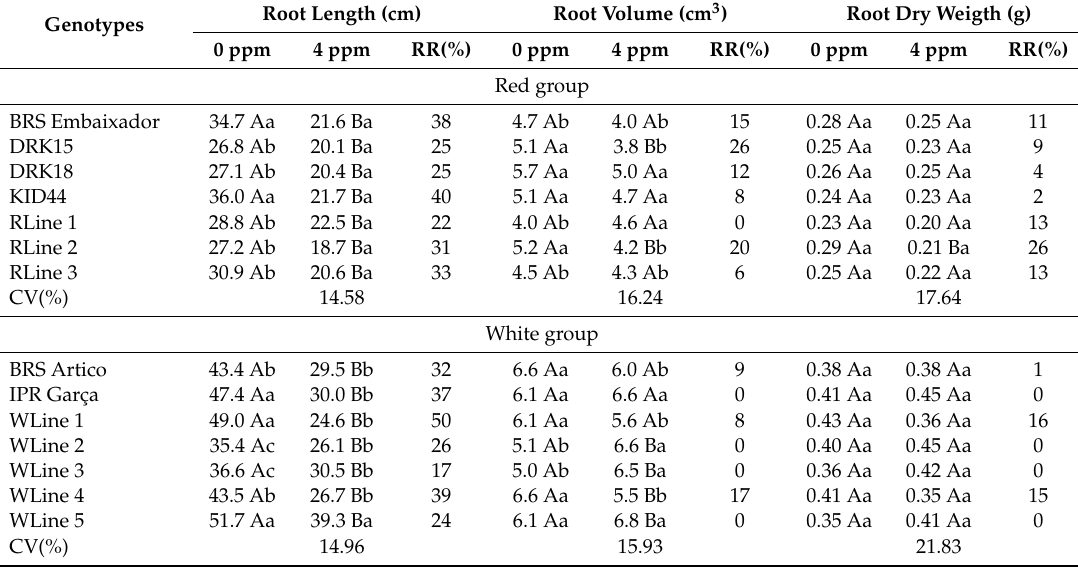
Figure 4. Relationship between root length (cm) of commercial bean cultivars of the market classes carioca ( A ) and black (B ) grown in Al-free nutrient solution (0 ppm) and exposed to Al-stress (4 ppm). Table 4. Common bean cultivars of Andean origin, red and white market classes, grown in Al-free and Al-contaminated nutrient